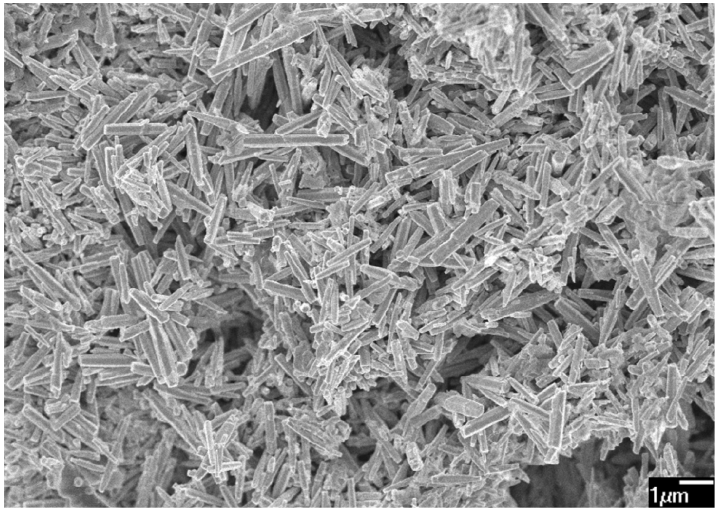
Figure 3. Scanning electron microscopy image of the zinc oxide